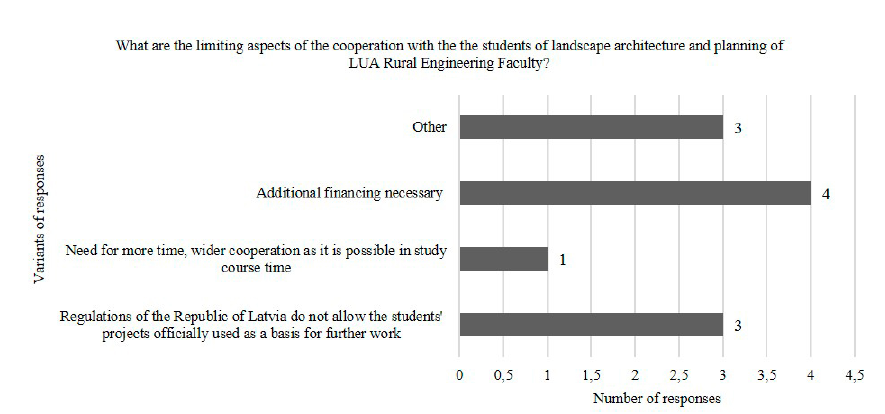
Fig. 4. Survey results about second